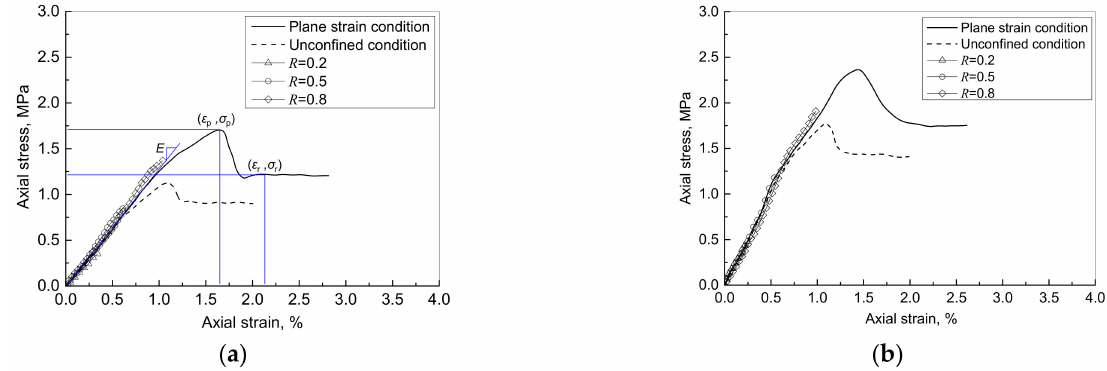
Figure 4. Stress-strain curves of specimen under static loading: ( a ) FC7; ( b ) FC9.